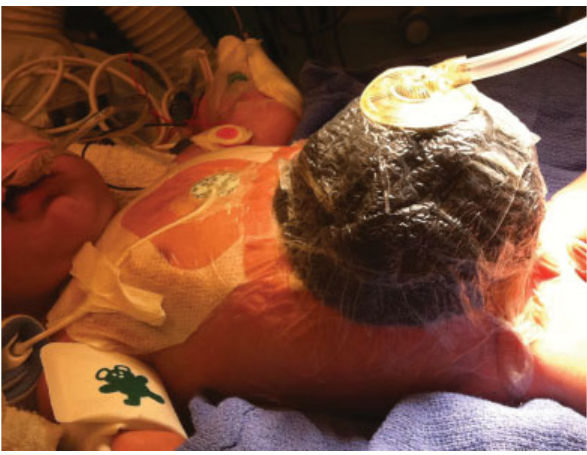
Fig. 3 Gastroschisis on day of life 39, 17 days after vacuum-assisted closure dressing was placed, showing dressing materials and nearly complete reduction of herniated abdominal contents.